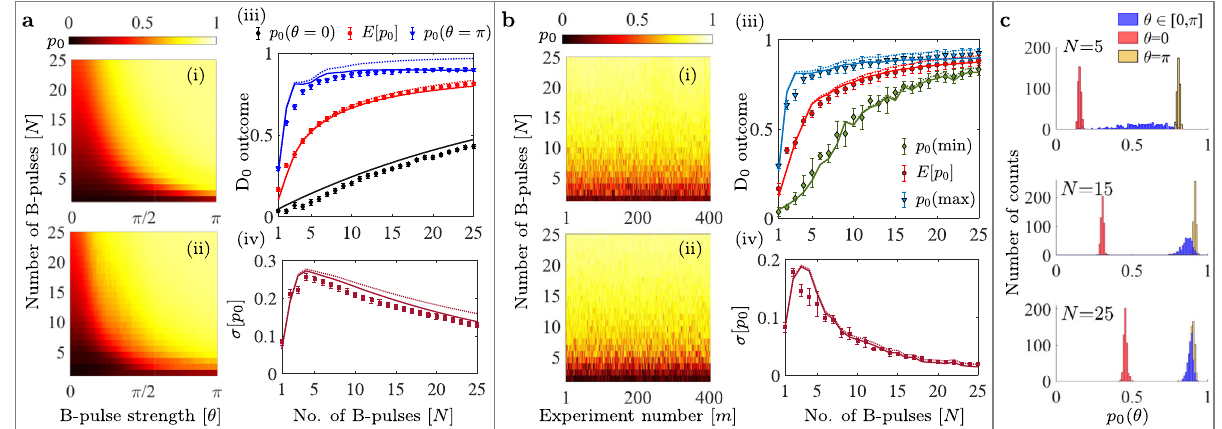
Fig. 6 | Results for the D 0 outcome in the case of multiple Ramsey sequences with B -pulses N ∈ [125] of varying strengths, θ j , m ∈ [0, π ] with j = 1 , N and m indexingtheexperimentalrealizationforagiven N .a Plotsforidentical B -pulses θ θ = m π = M foragiven N :(i)Simulatedand(ii)experimentallyobtainedmaps. j , m = (iii) Values of p 0 at B -pulse strengths θ =0, π and mean p 0 (E[ p 0 ]) versus N with markers with error bars showing the experimental results and the corresponding continuous lines obtained from the simulations. Red circular markers present the mean value E [ p 0 ], blackdiamond markerscorrespond tothecase withno B -pulses ( θ =0)anddatapointswithbluetriangularmarkersstandforthecaseofmaximum B -pulse strengths ( θ = π ). (iv) Standard deviation evaluated for a given N versus N . b Plots for arbitrarily chosen θ j , m ∈ [0, π ]: (i) Simulated and (ii) experimental data for p 0 asafunctionof N and m .(iii)Simulated(continuouslines)andexperimental